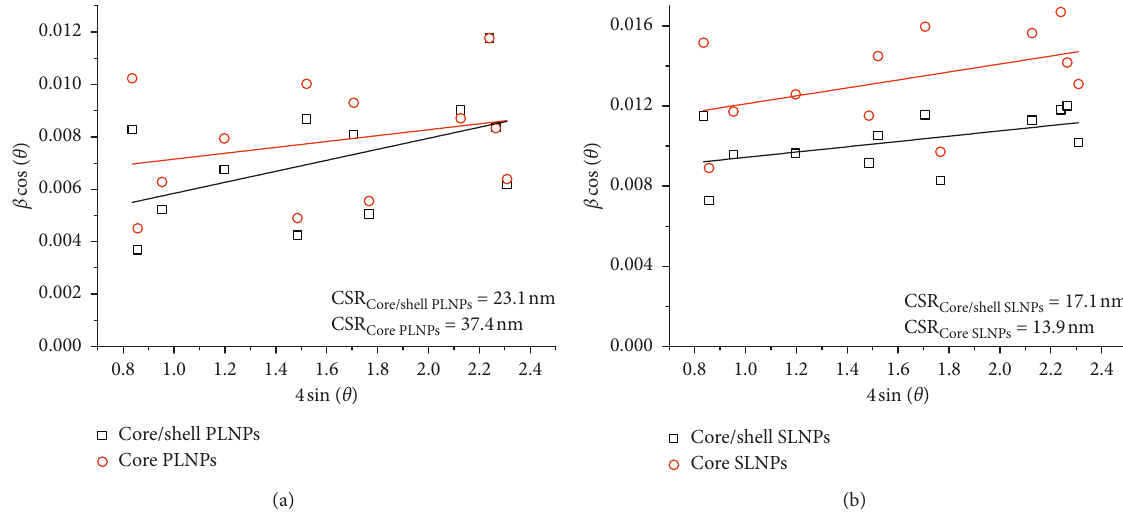
Figure 5: The Williamson–Hall plot of the (a) core nanoplates and core/shell nanoplates and (b) core nanospheres and core/shell